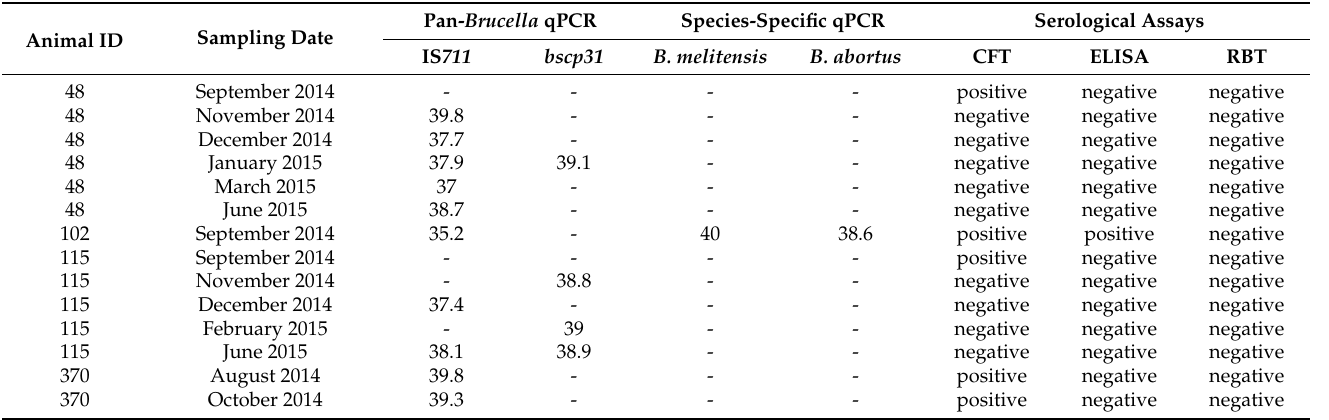
Table 6. Summary of the Cq values and serological results of the four animals that were PCR-positive for Brucella